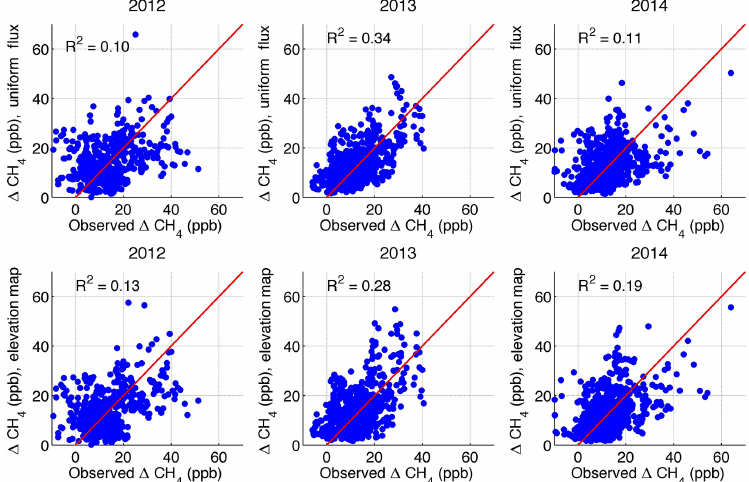
Figure 8. Optimized model (cid:49) CH 4 (ppb) for the scaled uniform flux (top row) and scaled elevation-based flux map (bottom row) for 2012 (left), 2013 (center), and 2014 (right); all plotted against observed (cid:49) CH 4 . Fluxes were scaled to match monthly average observed (cid:49) CH 4 with monthly scaling factors. The coefficient of determination, R 2 , is indicated in each plot, along with the one-to-one line. Data points represent hourly averages between 13:00 and 18:00LST filtered according to criteria described in the text.